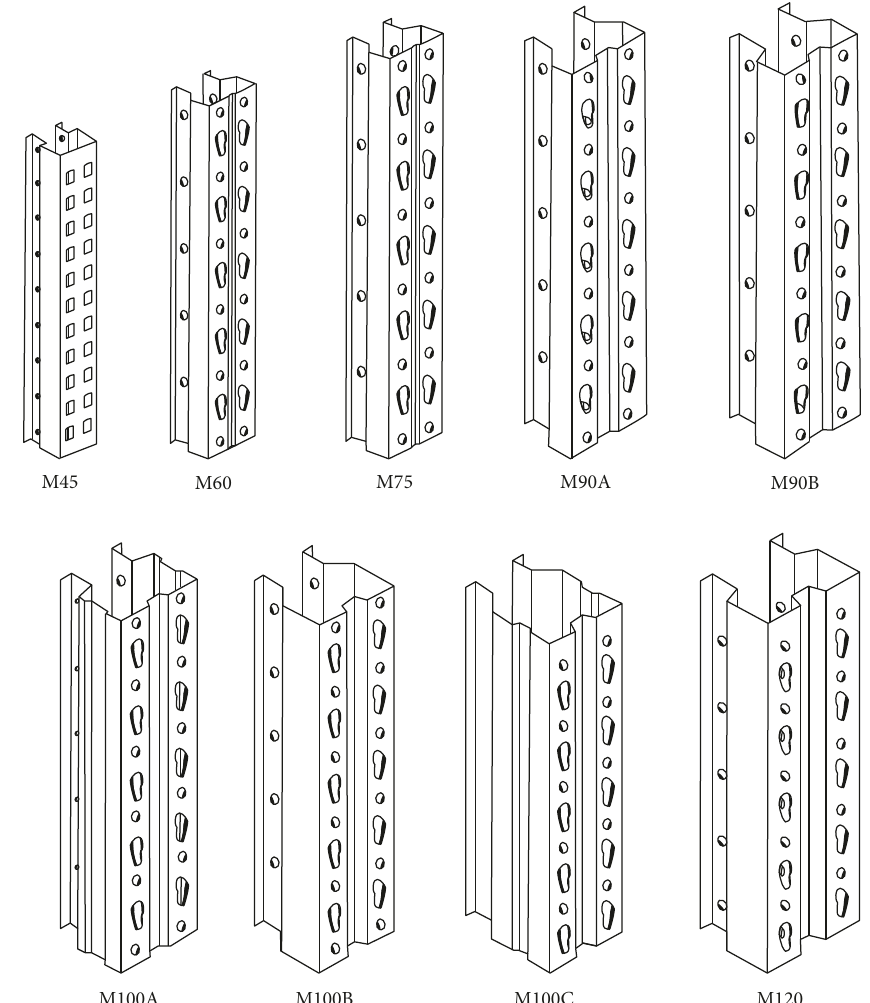
Figure 7: 3D models of stub column.